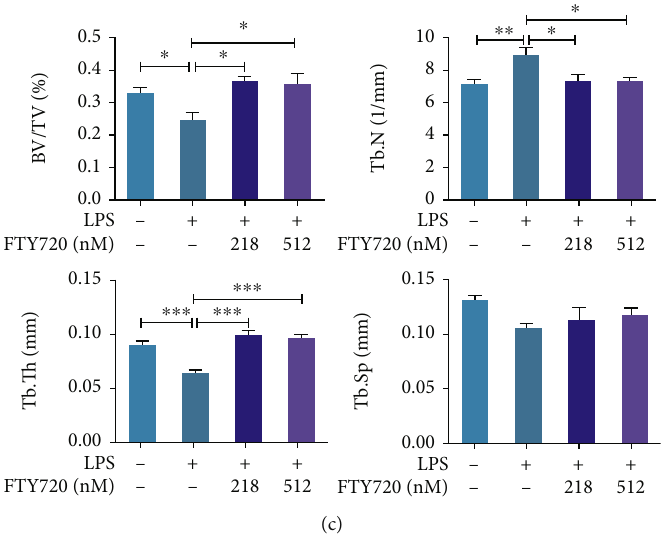
Figure 4: FTY720 restored lipopolysaccharide- (LPS-) induced cranial osteolysis. (a) Reconstruction of cranial bone models by micro-CT upon treatment with PBS, LPS, or LPS and FTY720 (128nM or 512 nM) together under di ff erent conditions. (a – d) 3D reconstructed images of the whole skull with a scale of 2mm. ((a), A1 – D1, A2 – D2) The selected region of interest in the median part of the skull and the cranial suture images, respectively, corresponding to scales of 1mm and 500 μ m. (b) Quantitative analysis of the data from the PBS ( n = 6 ), LPS ( n = 6 ), and LPS with low ( n = 5 ) or high ( n = 5 ) FTY720 groups collected by micro-CT in the median cranial region for bone volume fraction (BV/TV), trabecular number (Tb.N), subchondral trabecular thickness (Tb.Th), and trabecular separation (Tb.Sp). (c) Quantitative analysis of the data from the PBS ( n = 6 ), LPS ( n = 6 ), and LPS with low ( n = 5 ) or high ( n = 5 ) FTY720 groups collected by micro-CT analysis of the cranial suture for BV/TV, Tb.N, Tb.Th, and Tb.Sp. Data are expressed as the mean ± SEM . ∗ P < 0 : 05 , ∗∗ P < 0 : 01 , ∗∗∗ P < 0 : 001 by one-way ANOVA with Tukey ’ s post hoc test (b,